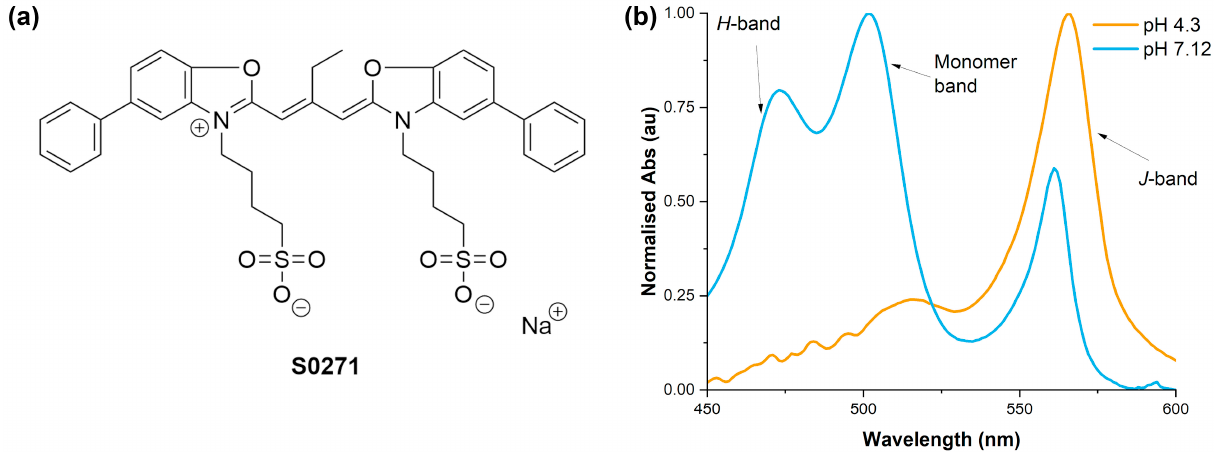
Figure 1. ( a ) The structure of the cyanine dye S0271 used in this study. ( b ) Two normalised visible spectra of S0271 solutions at different pHs which highlight the absorption bands of the monomer and H - and J -aggregates.